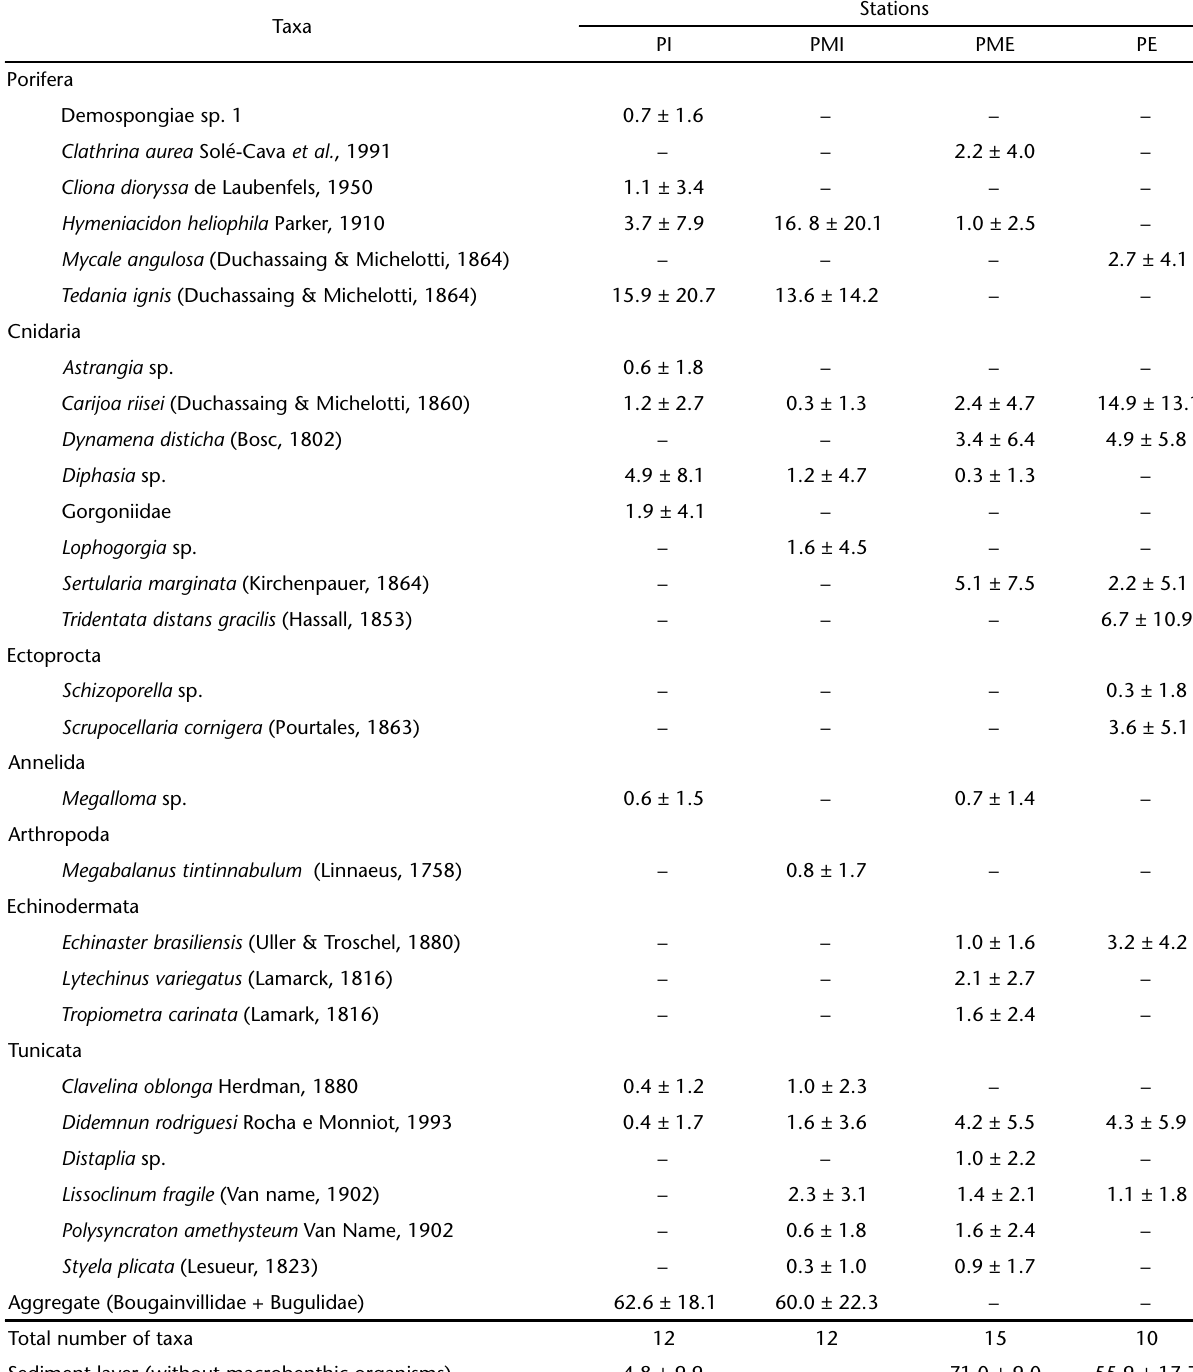
Table II. Mean values of percent cover ± standard deviation for the taxa and for the sediment layer (without macrobenthic organisms) recorded at the four study stations PI (Inner Station), PMI (Inner Midpoint), PME (External Midpoint) and PE (External Station) along the Vitoria Harbor (N = 5 quadrats on six sampling